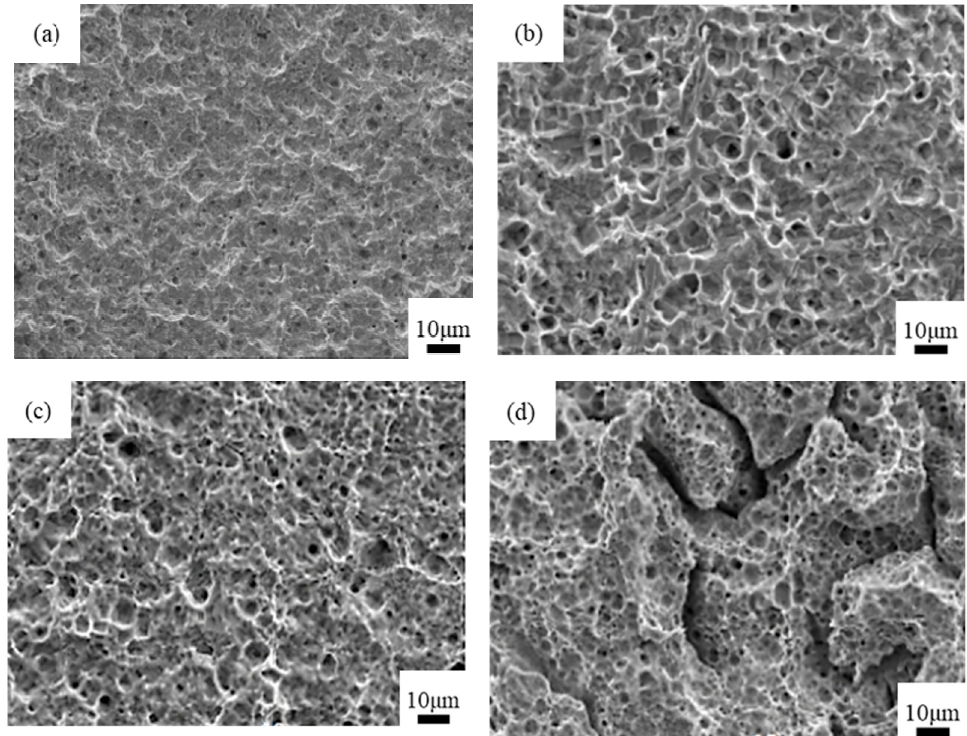
Figure 7. SEM images of copper surface treated with different concentrations of phosphoric acid. ( a ) 16%; ( b ) 18%; ( c ) 20%; ( d ) 22%.